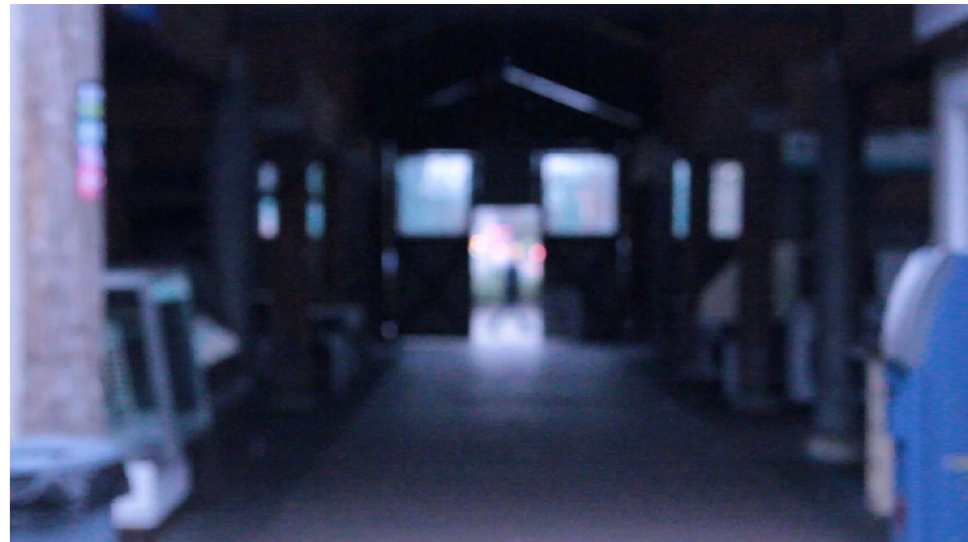
Figure 1. All the Courtesy of Love (2020). Digital film still. https://vimeo.com/showcase/9841426/video/391018843 (accessed on 26 September 2022).